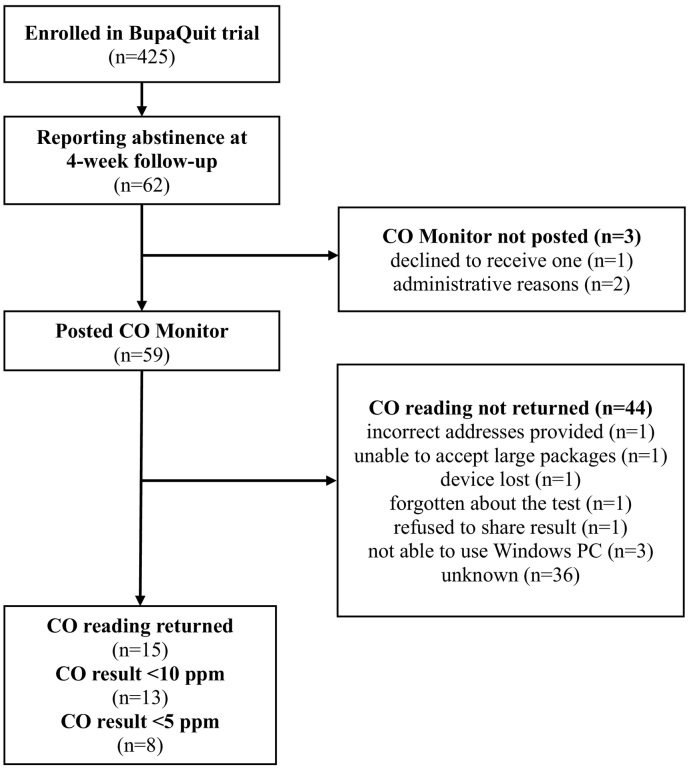
Participant flow through BupaQuit trial and CO testing procedure.